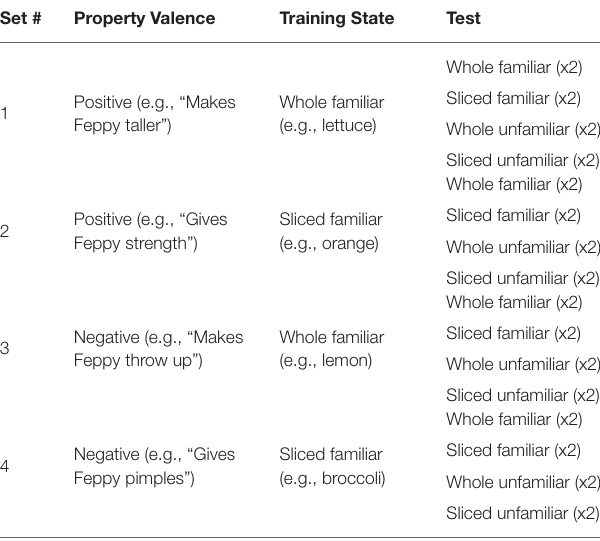
TABLE 2 | Experimental